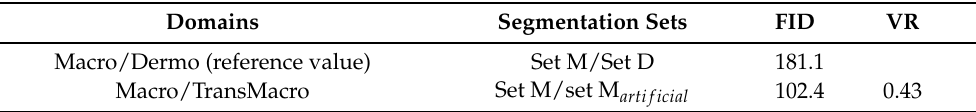
Table 4. Fréchet Inception Distance (FID) and Variation Ratio (VR) results between set M, set D and set M artificial